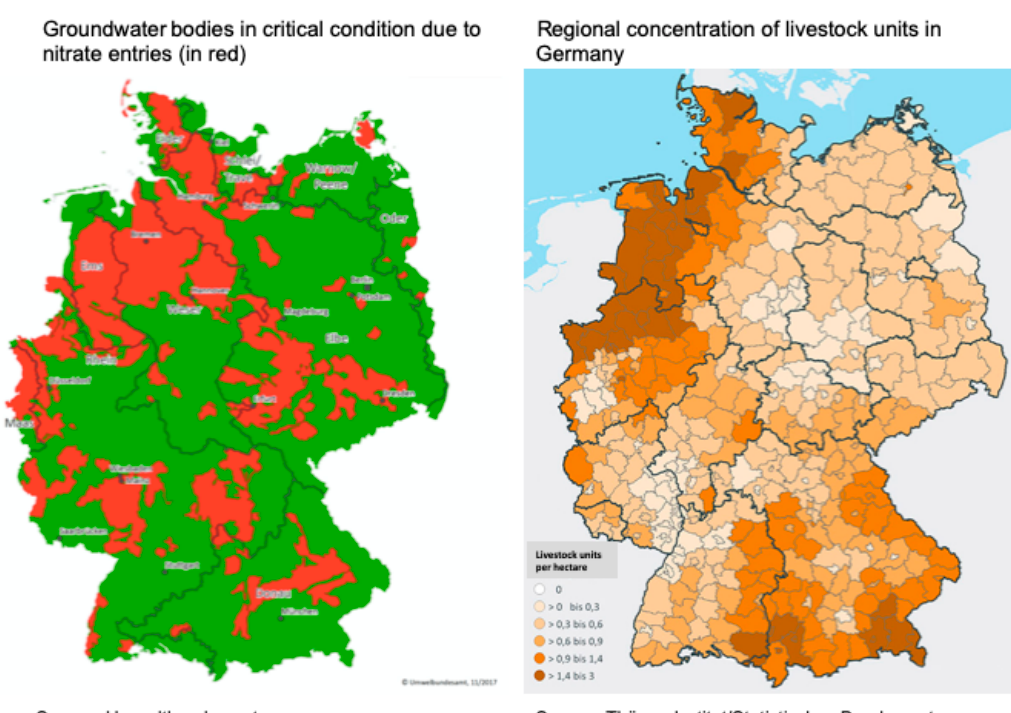
Figure 2. Nitrate entries in groundwater bodies compared to the regional concentration of livestock units in Germany. Sources: Umweltbundesamt, Thünen Institut [46,47]